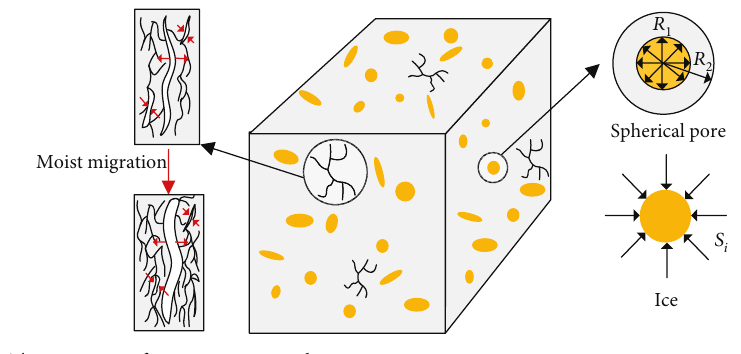
Figure 14: (a) Diagram of mineral particle shrinkage after LN preconditioning. during LN 2